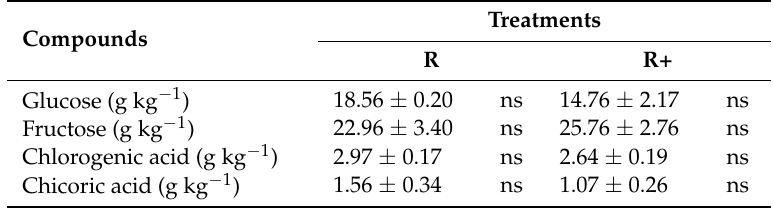
Table 3. Sugars and phenolic acid content in the dry biomasses of monocultured and intercropped red chicory. Different letters indicate significant differences ( p < 0.05) among treatments for each parameter, according to the Tukey’s HSD test. ns = not significant differences. Treatments Compounds R R+ Glucose (g kg − 1 ) 18.56 ± 0.20